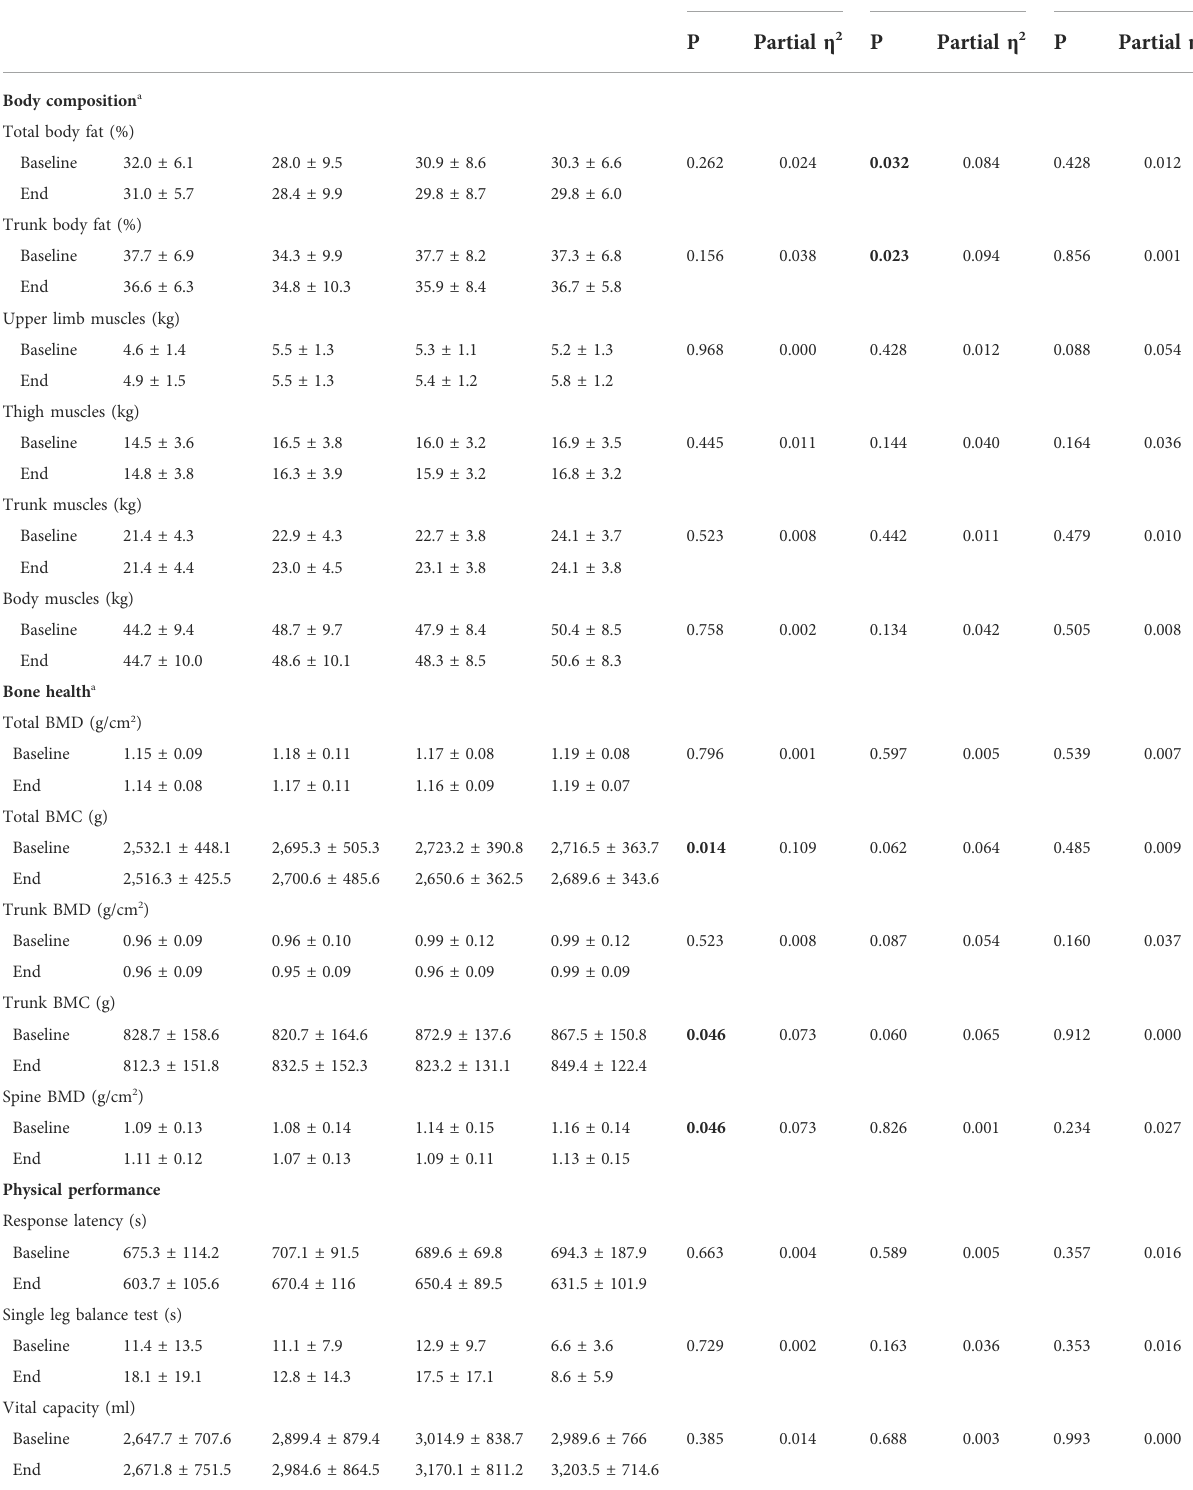
TABLE 2 The parameters of body composition, bone health and physical performance by four groups at baseline and at end.